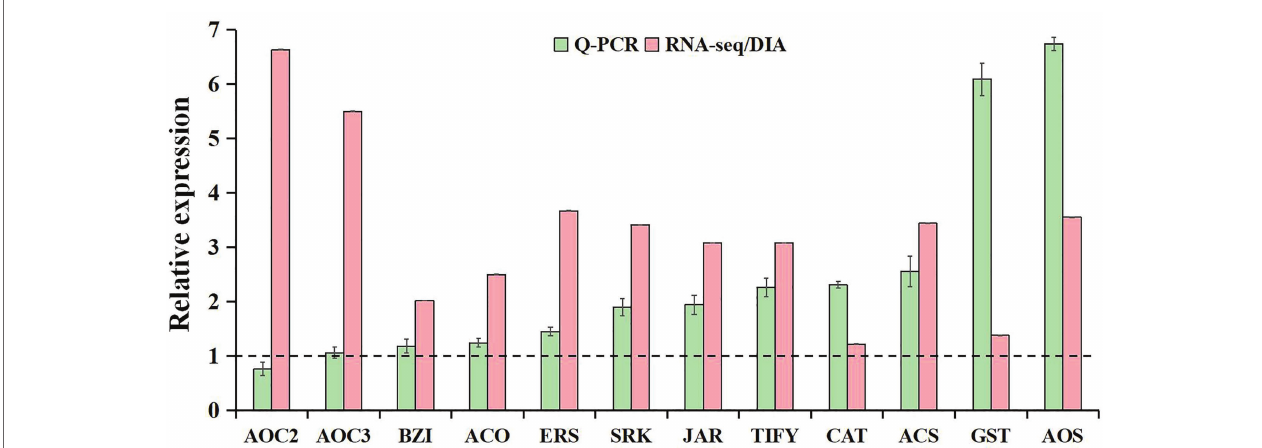
FIGURE 7 | Comparative analysis of mRNA and RNA-seq or protein levels in leaves between rapeseed cultivar NF and cultivar NS under freezing stress. The data in the leaves of NF under freezing treatment were set to 1.0. Values are means ± SD (from three biological replicates) in NS leaves under freezing